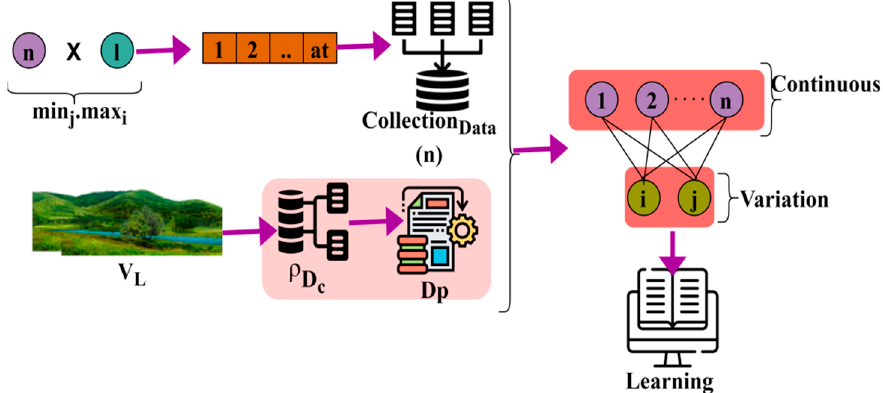
Figure 3. Continuous data process.